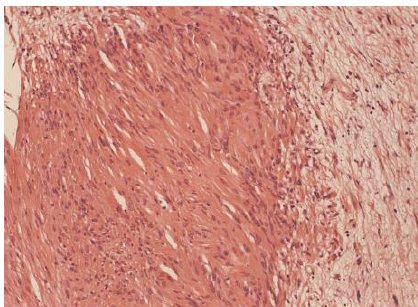
Figure6:AntoniAareaontheleftwithdensecellularityandnuclear palisading. Antoni B area on the right demonstrating loose array of the cells. E&H stain